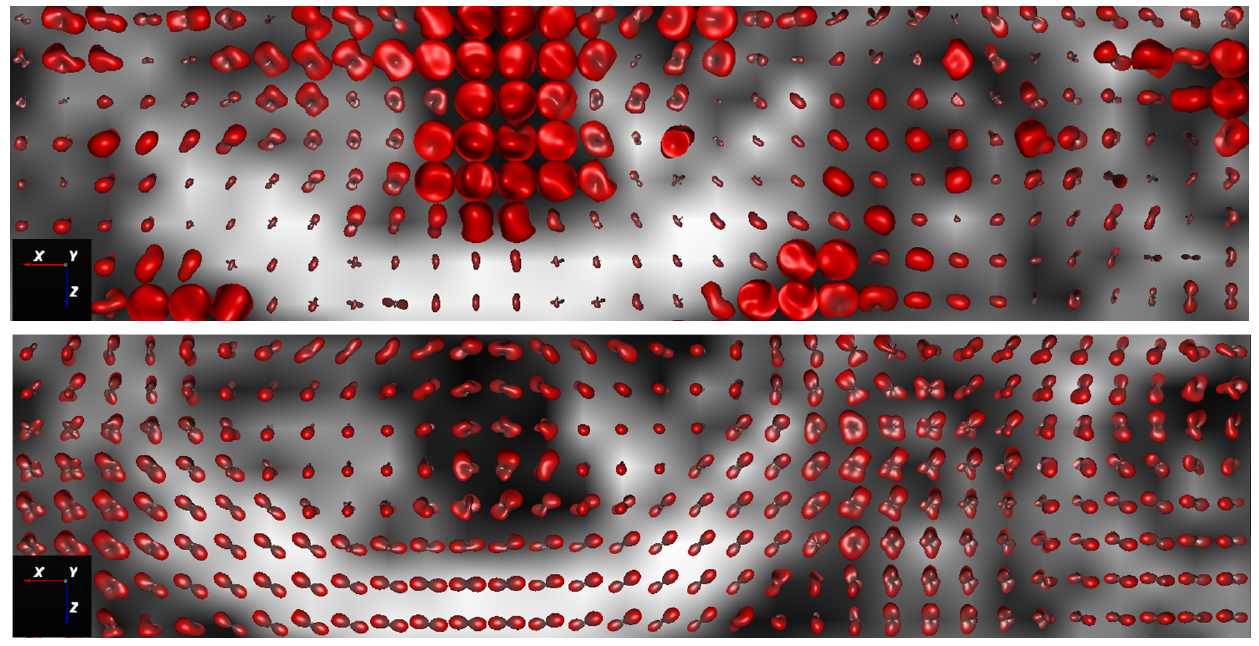
Figure 4. Inverted fourth order orientation distribution function (ODF) field ( top ) and its corresponding ODF field ( bottom ) from part of the centrum